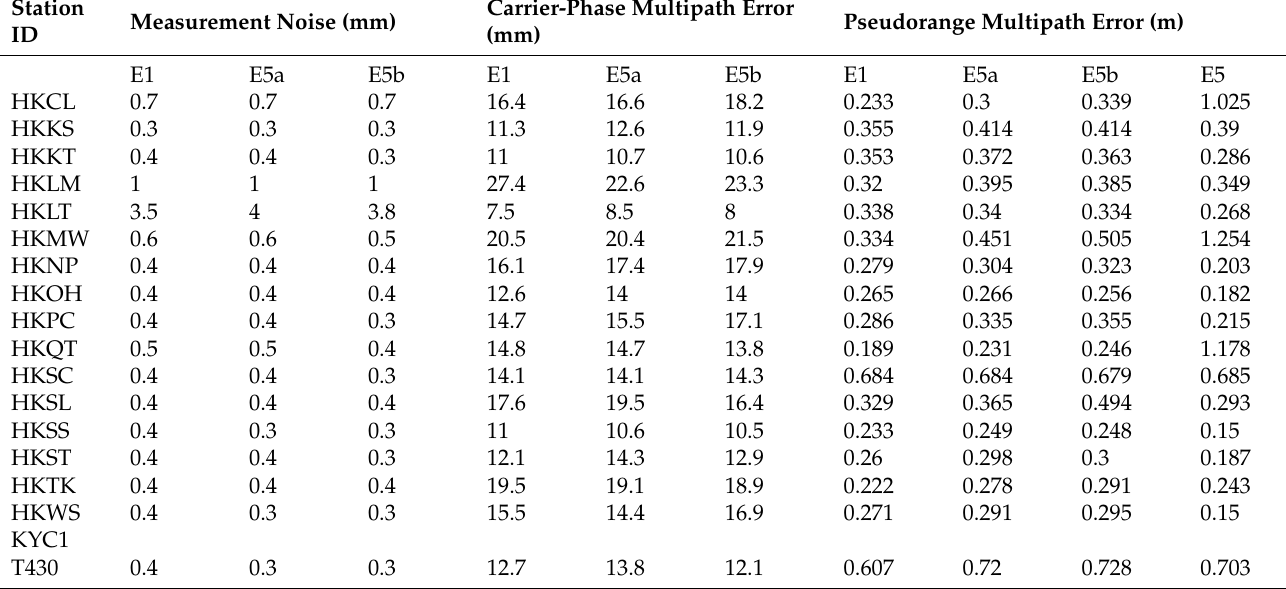
Table A3. Carrier-phase measurement noise, pseudorange, and carrier-phase multipath errors of the Hong Kong SatRef Galileo three-frequency measurements at a 95% confidence level.